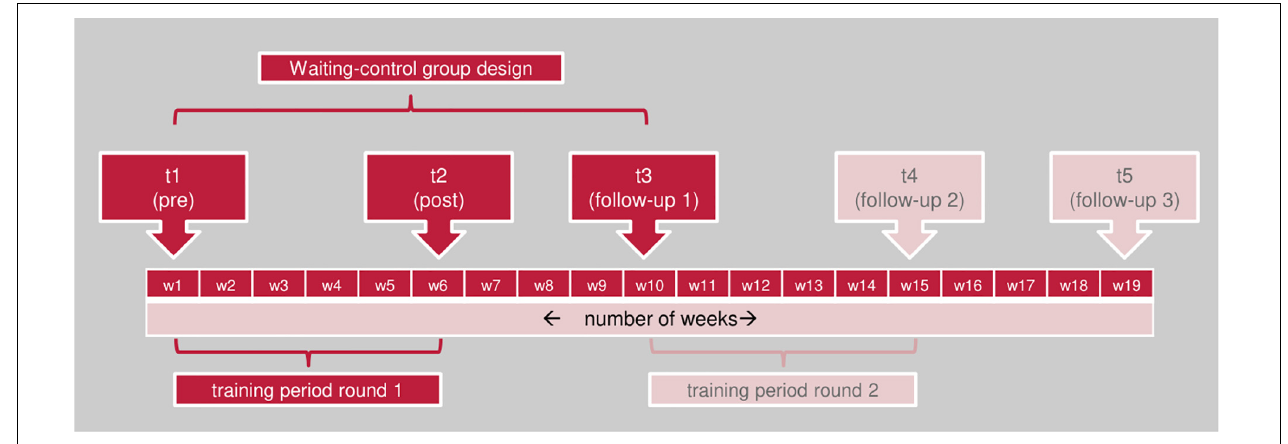
FIGURE 2 | Study design and measurement